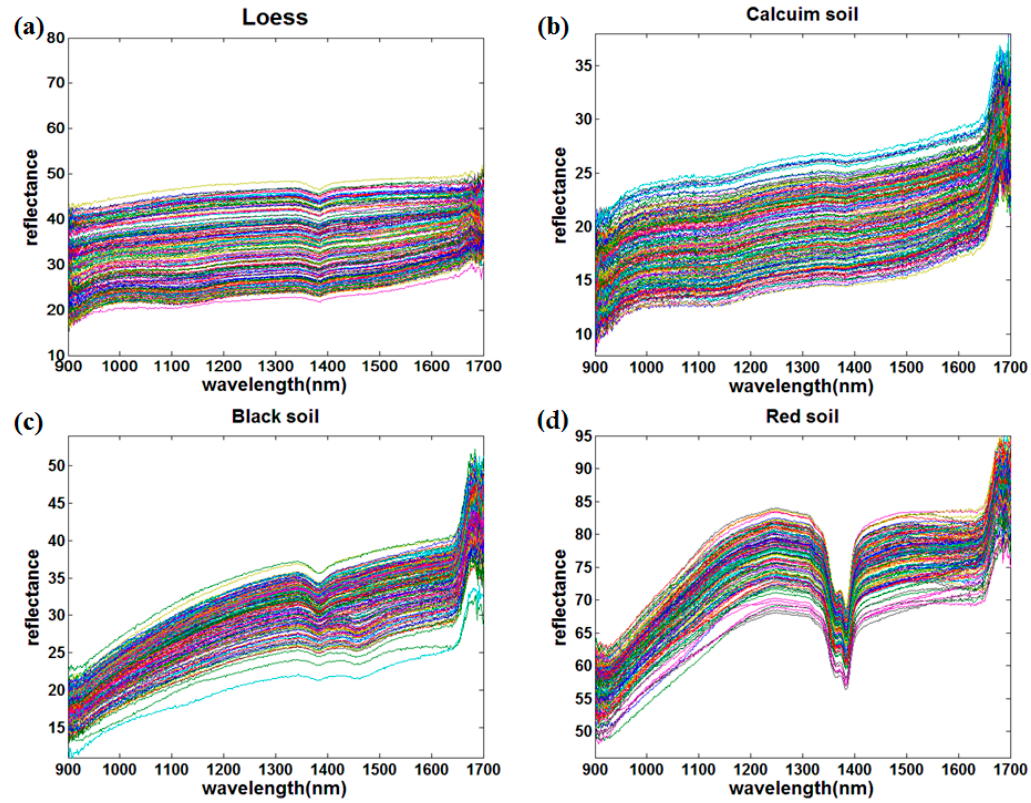
Figure 1. The original near infrared (NIR) curves of four kinds of soils. ( a ) Loess; ( b ) Calcium soil; ( c ) Black Soil; ( d ) Red soil.